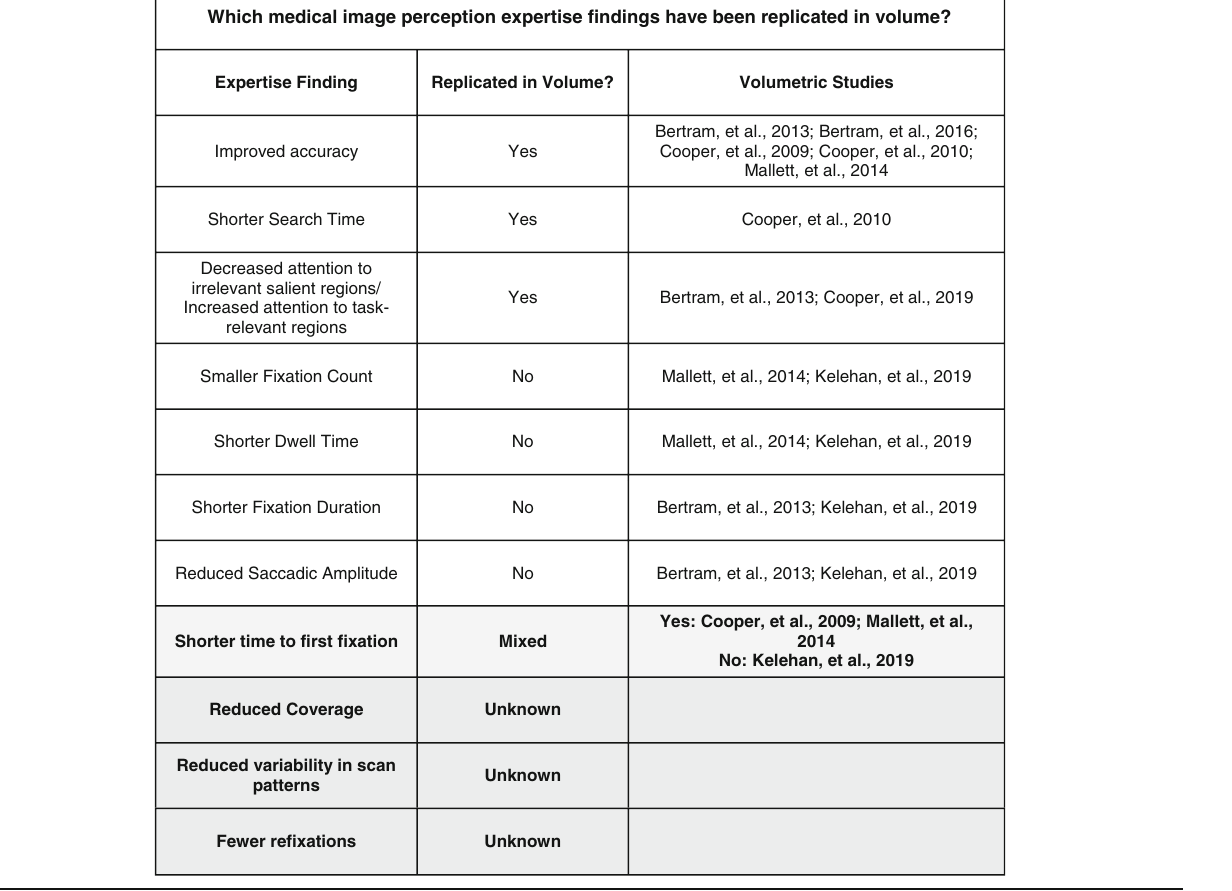
Table 2 A list of common expertise-related findings in two-dimensional images. Many of these basic expertise findings have either not replicated or not yet been tested in volumetric images (particularly using free-scroll paradigms with stacked images) Which medical image perception expertise findings have been replicated in